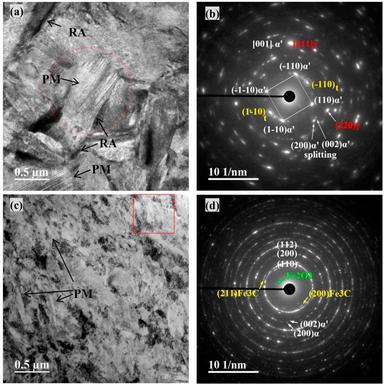
TEM images with corresponding indexed diffraction patterns showing WEL structure at the topmost regions. (a) TEM and (b) SAED of rail sample A; (c) TEM and (d) SAED of rail sample B. The finer nanostructure of sample B is indicated by both the bright-field and selected area diffractions patterns.